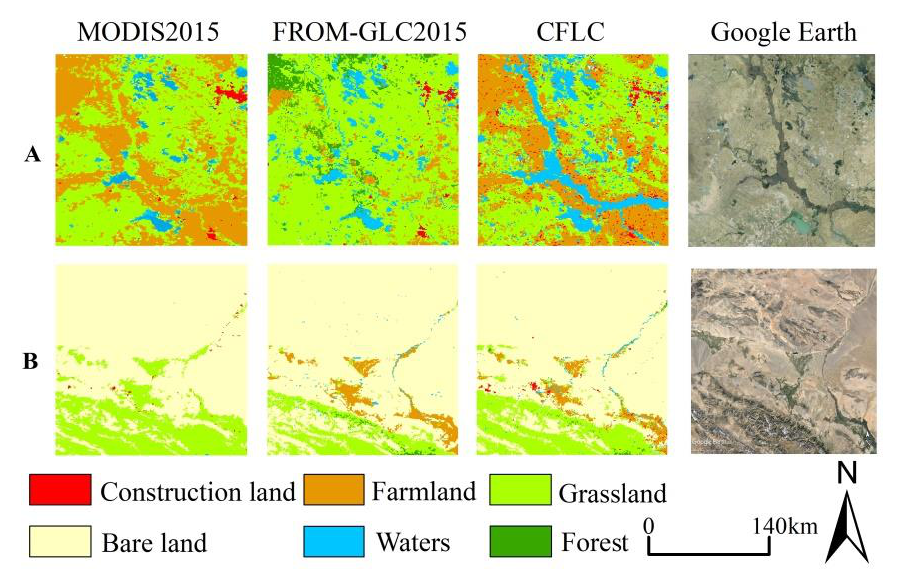
Figure 5. Local differences among the three land cover maps. The region ( A ) is located in Nenjiang River basin in Qiqihaer with a central coordinate of 124.21°E and 45.99°N, and the region ( B ) is located in Jinta County in the Heihe River Basin in Northwest of China, with central coordinates of 98.87°E, 40.24°N.